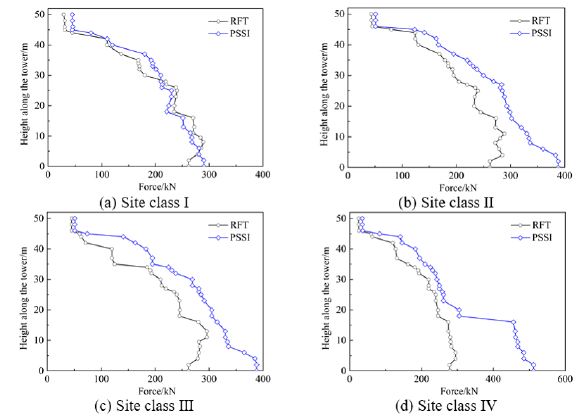
Fig. 11. Axial force value of main materials. site conditions is shown in Fig.